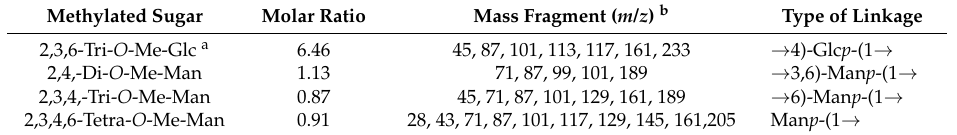
Figure 4. Proposed structural feature of the BEPS-IA isolated from B. exarata . Table 2. GC-MS of alditol acetate derivatives from the methylated product of BEPS-IA. Methylated Sugar Molar Ratio Mass Fragment ( m / z )